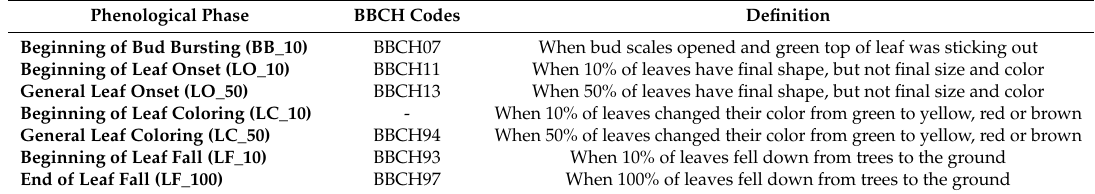
Table 2. Definition of the phenological phases observed in all study